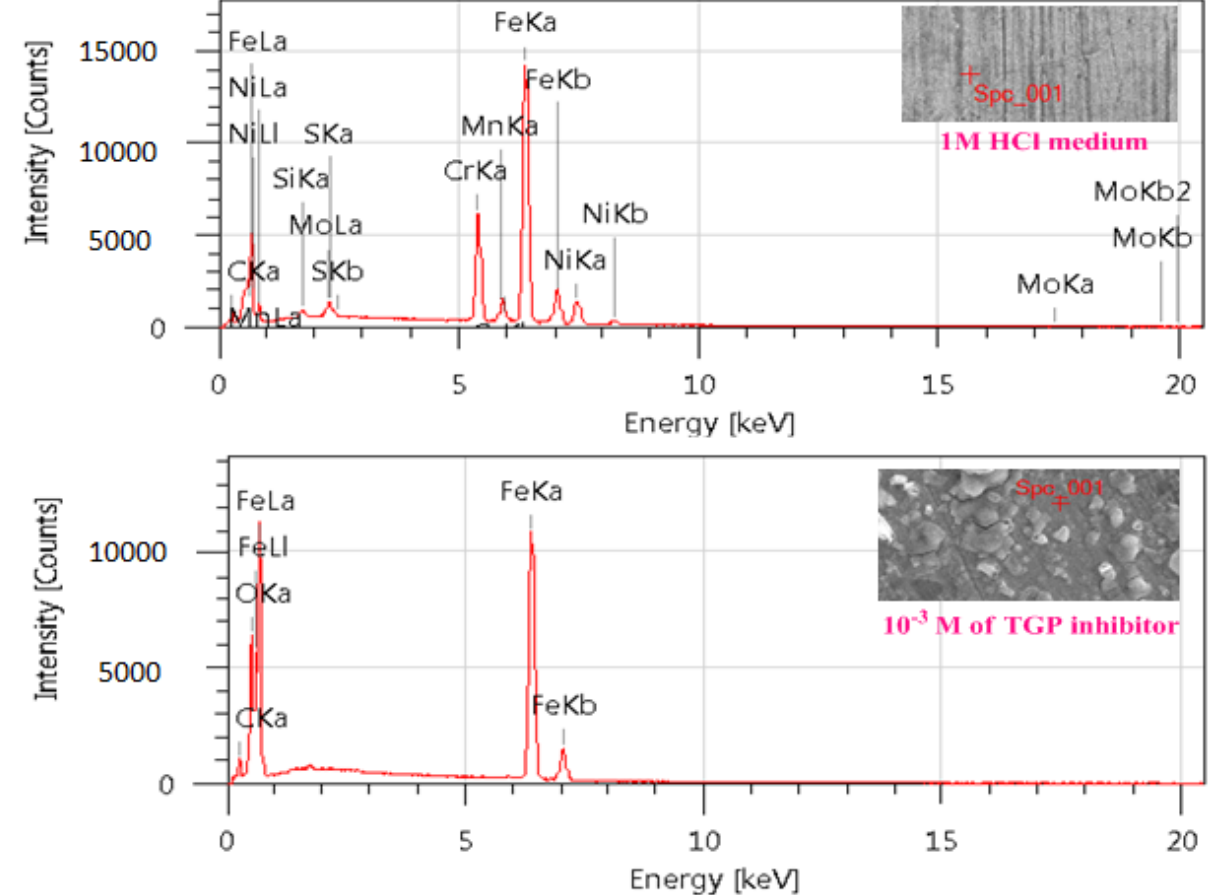
Figure 6. EDS spectra for MS electrode after immersion in 1 M HCl medium for both unprotected and protected by 10 − 3 M of TGP.